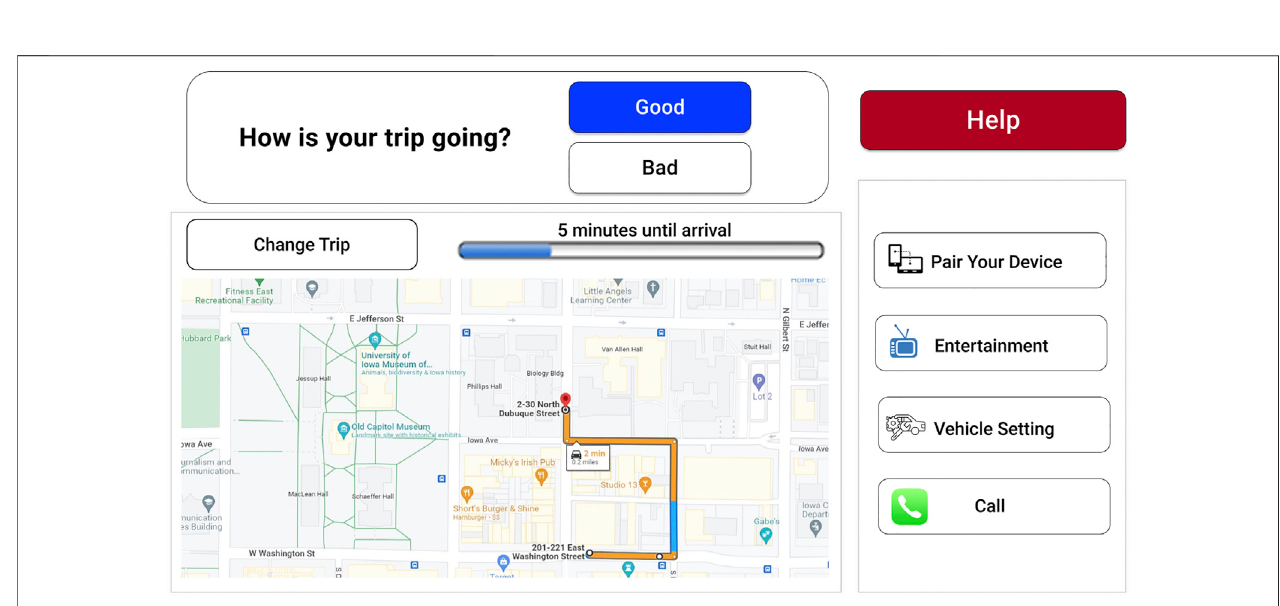
FIGURE 5 | Prototype of the refuel/recharge the vehicle reminder (vehicle is rerouting to the nearest gas station).